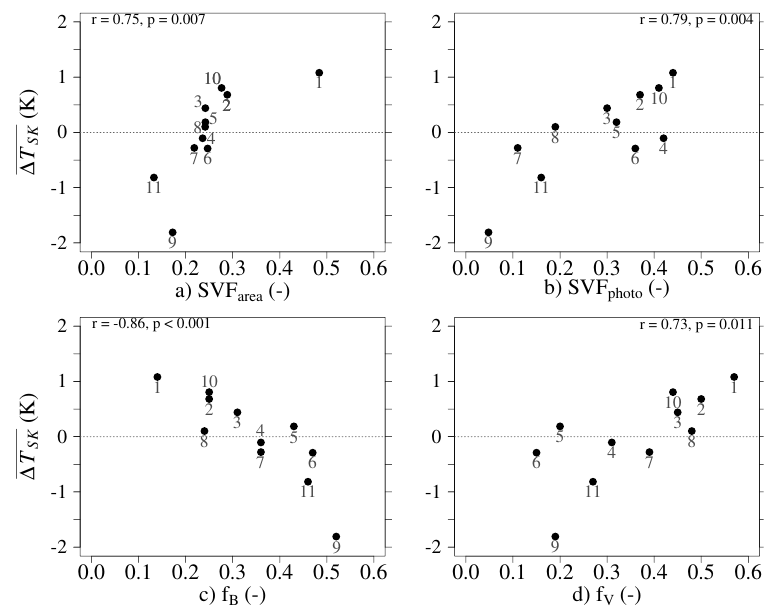
Figure 6. Daytime mean difference of each individual air temperature ( T ) to the spatial mean daytime T of all sites ( ∆ T SK ) at each measurement site within the Schillerkiez in relation to different urban morphometric parameters ( a – d ) on 24 June 2016. Correlation coefficients (r) and corresponding p -values are given for each parameter. SVF area : areal sky view factor, SVF photo : sky view factor calculated from fish-eye photos, f B : building surface fraction, f V : vegetation surface